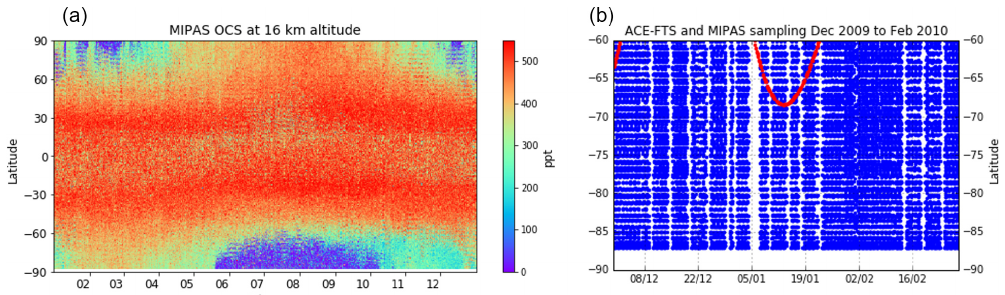
Figure 4. The equivalent to Fig. 1a with the MIPAS OCS data set from 2008 to 2011 (a) and the sampling pattern of ACE-FTS in red and MIPAS in blue between 60 and 90 ◦ S, December 2009 to February 2010 (b) . The OCS color scale is identical to that in Fig. 1.